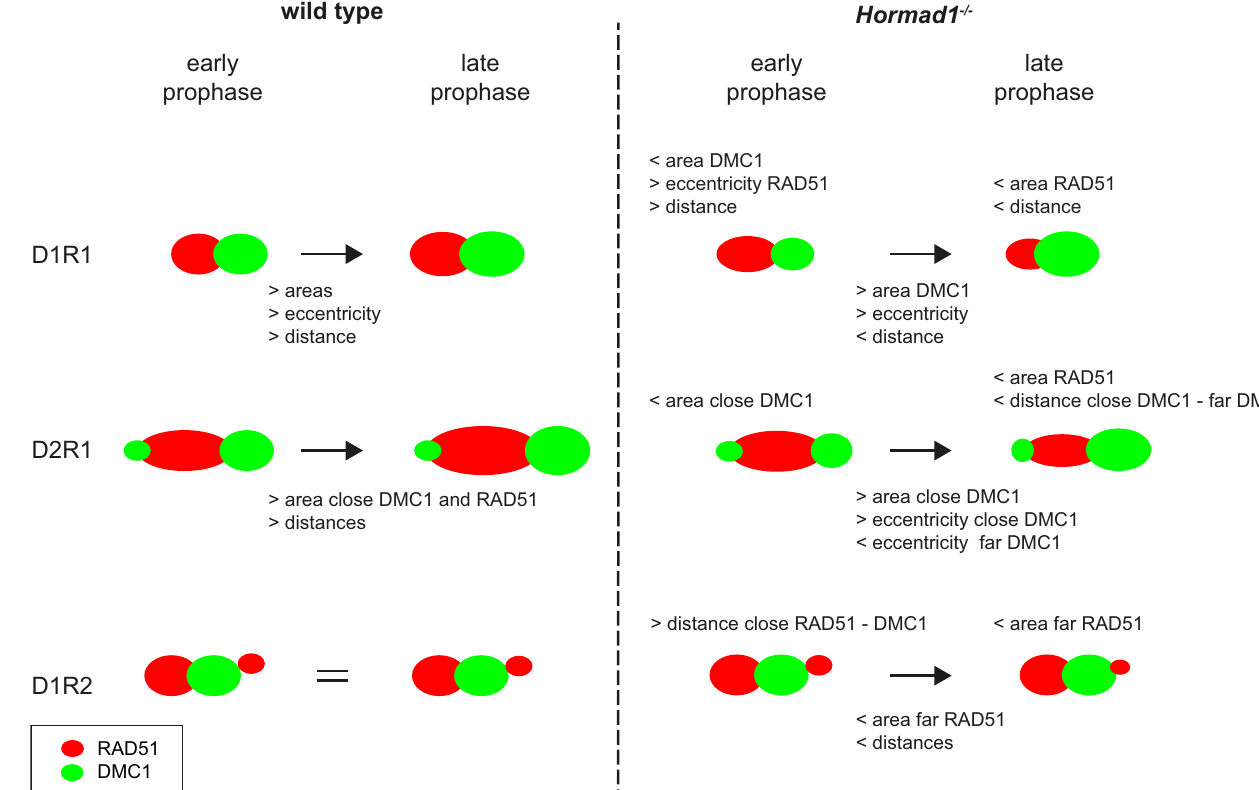
Fig 6. Schematic overview of alterations in D1R1, D2R1 and D1R2 configurations during meiotic prophase for wild type and Hormad1 -/- . Summary of alterations in area, eccentricity and internal distances. The left images schematically represent the consensus configurations in wild type, and how they change over time indicated by the text below the arrows. For D1R2 no change over time was observed, indicated by =. On the right side, the same is shown for Hormad1 -/- , and differences with wild type that exist in early or late prophase are described above the relevant schematic configurations. RAD51 is red and DMC1 is green.